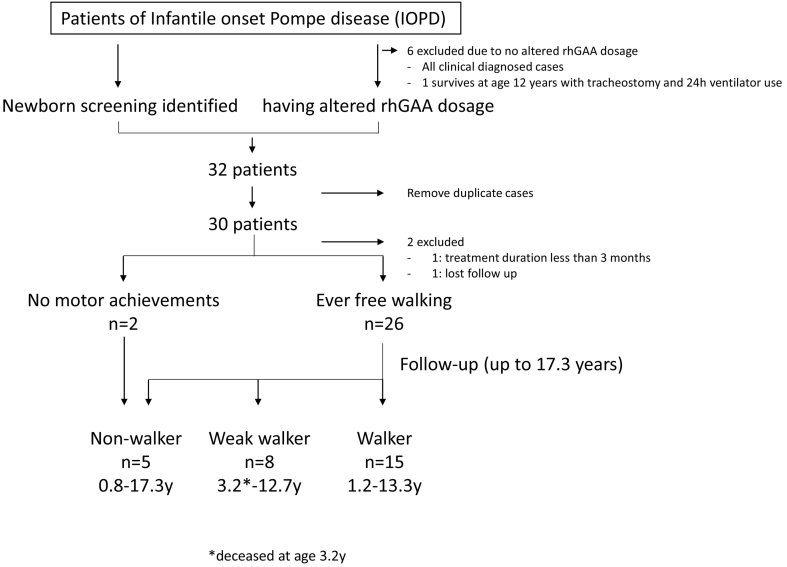
Patient flow and outcome of IOPD patients concerning current motor function.